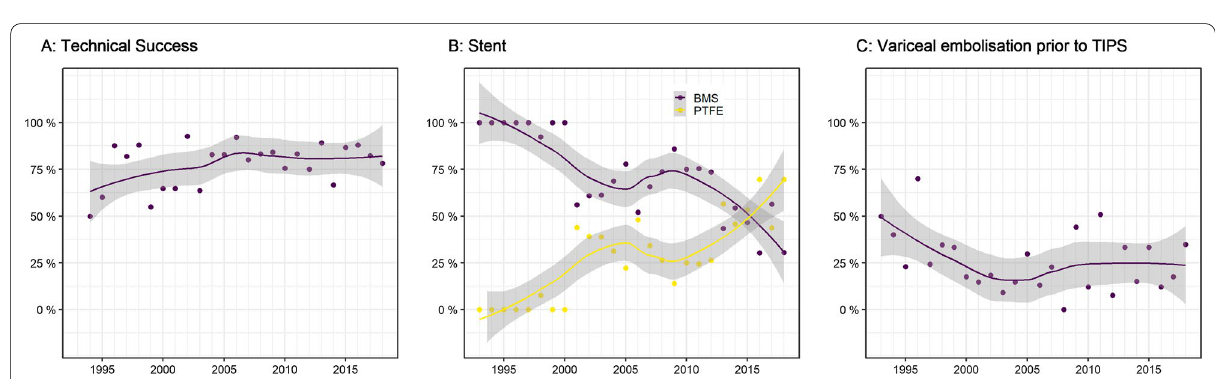
Fig. 5 Procedural data. a Trend in the technical success rate over 25 years. Primary technical success rate in total: 77.9%, secondary technical success rate in total: 84.9%. b Stent type use over time. c Variceal vein embolization prior to